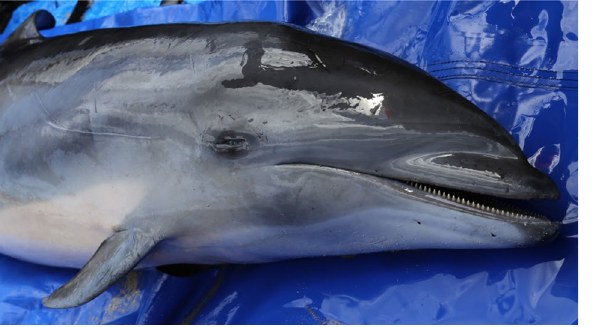
Figure 1. The sub-adult male Fraser’s dolphin ( Lagenodelphis hosei ) that stranded at Olowalu, Maui, Hawaii. Photo courtesy of Cindy